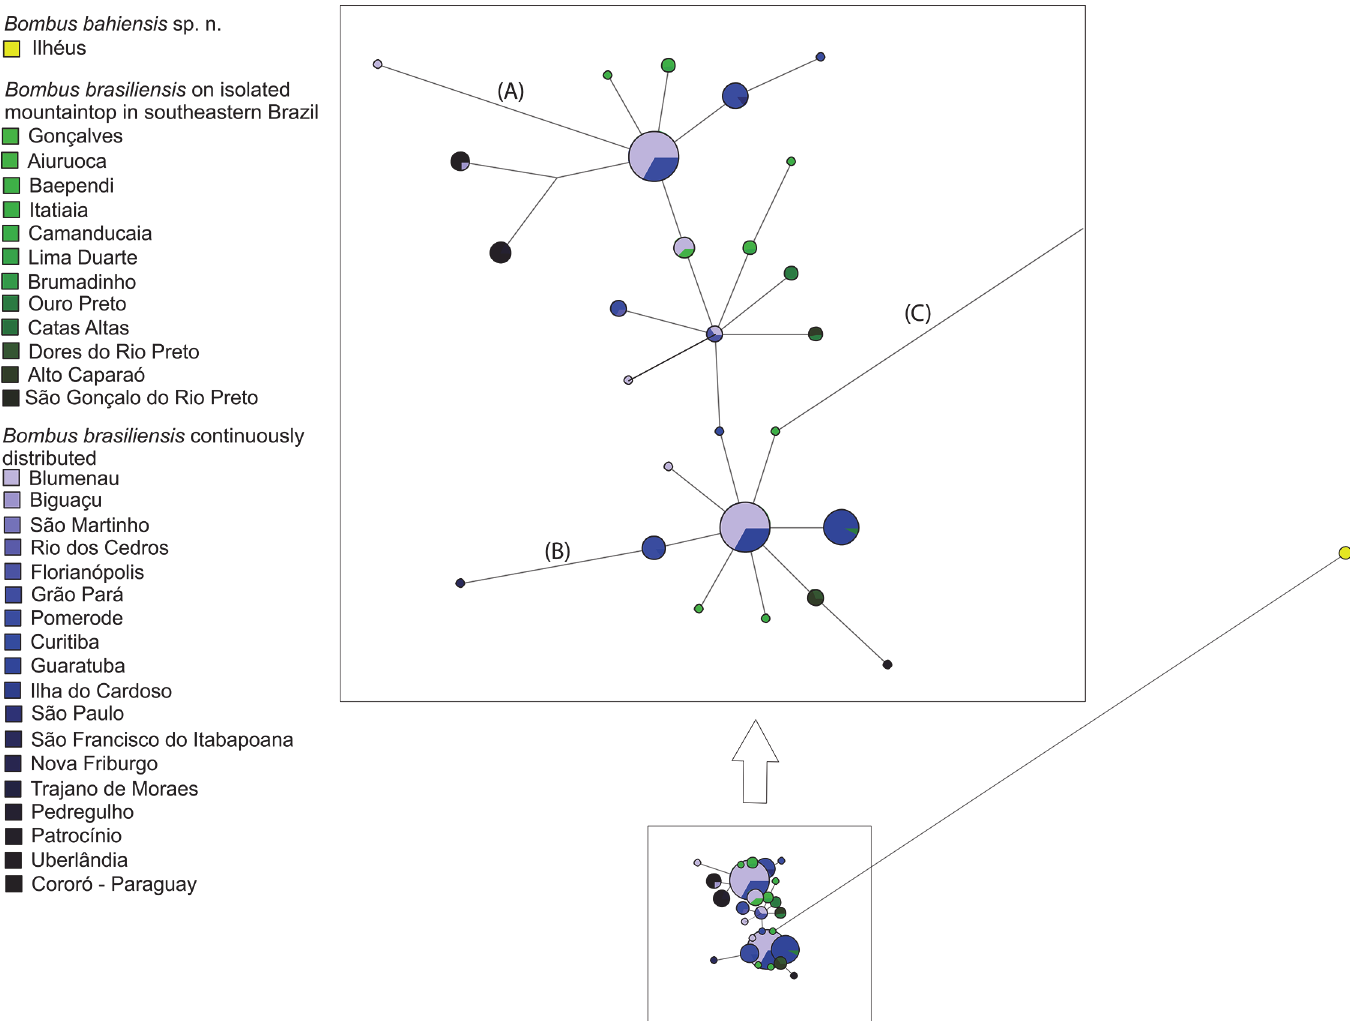
Fig 2. Network of haplotypes for Bombus brasiliensis Lepeletier, 1836 and Bombus bahiensis sp. n. Median-joining network of haplotypes for B . brasiliensis and B . bahiensis sp. n. The B . brasiliensis on isolated moutaintops in southeastern Brazil are coloured of different shades of green and the B . brasiliensis continuously distributed are coloured of different shades of blue. B . bahiensis sp. n. is coloured yellow. All lines joining haplotypes are one mutation step long, except for three of them, marked with “ a ” , “ b ” and “ c ” , which are three, two and 38 steps long, respectively.